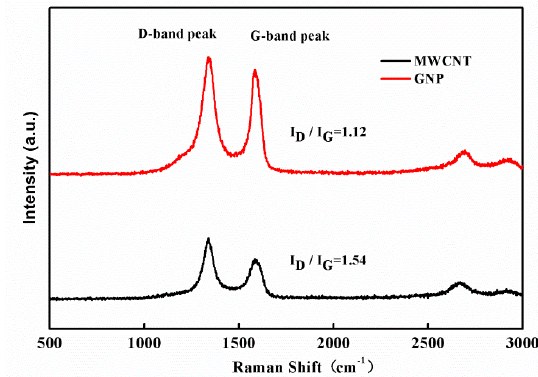
Figure 1. Raman spectrum of the graphene nanoplatelets (GNPs) and the multi-walled carbon nanotubes